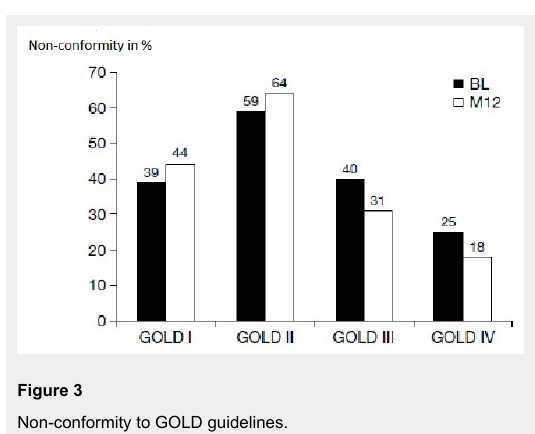
Non-conformity to GOLD guidelines. Comparison of guideline aberrant treated patients at BL and after 12 months. Abbreviations: GOLD, Global Initiative for Chronic Obstructive Lung Disease; BL, baseline; M12, month